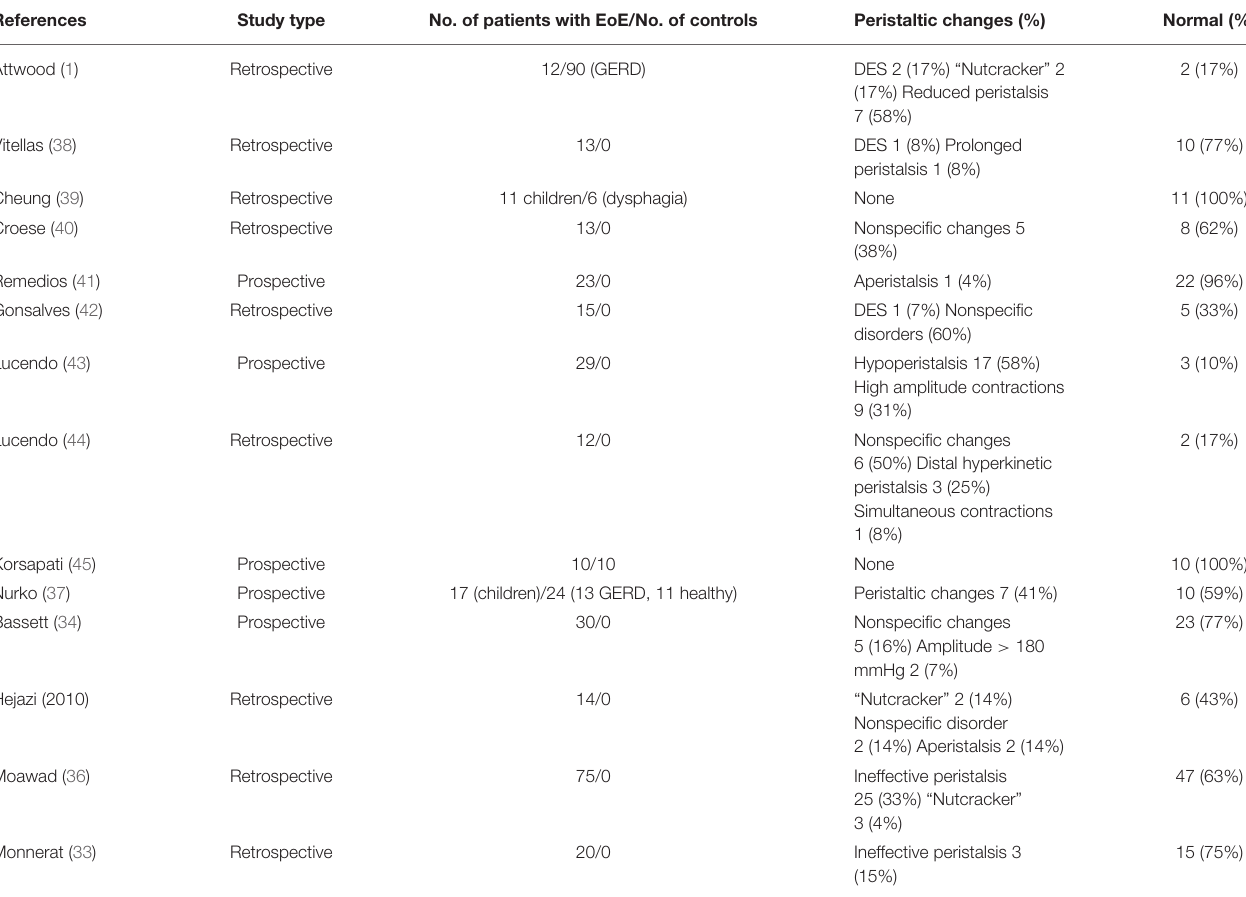
TABLE 1 | Conventional manometry studies in eosinophilic